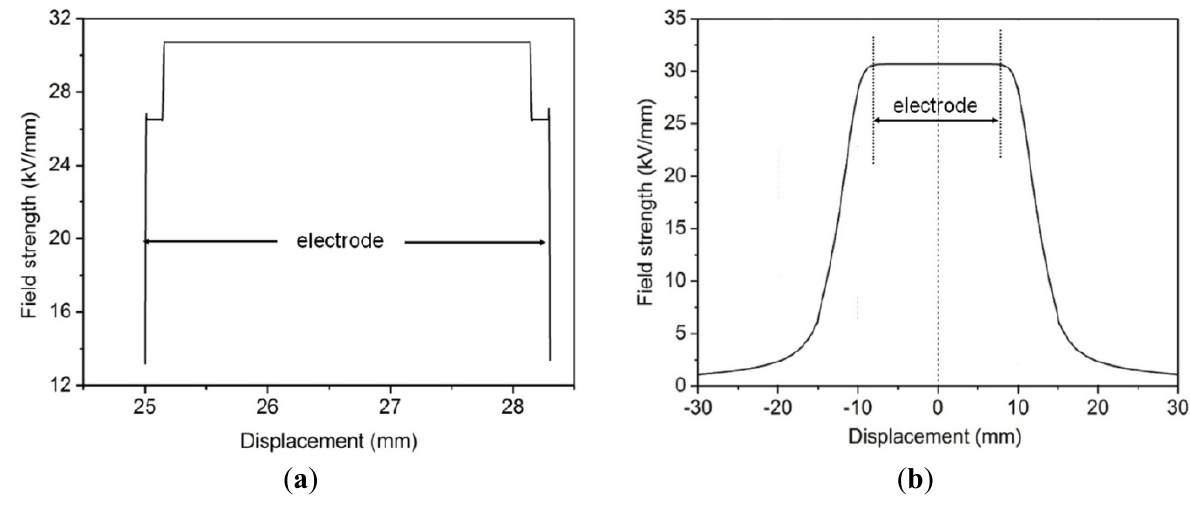
Figure 6. Electric field distribution: ( a ) line ab is the x -axis, and the bottom center of the ground electrode is the origin; ( b ) the vertical direction of line ab is the x -axis, and the center of the oil gap is the